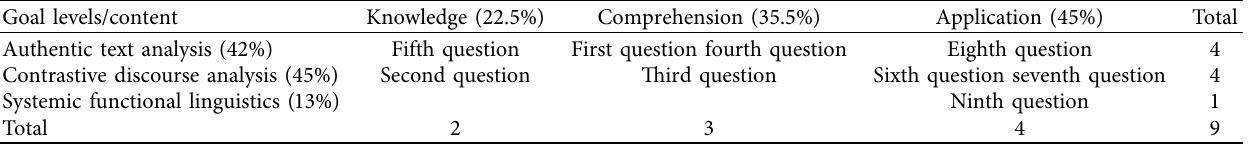
Table 1: Specifications of the English achievement